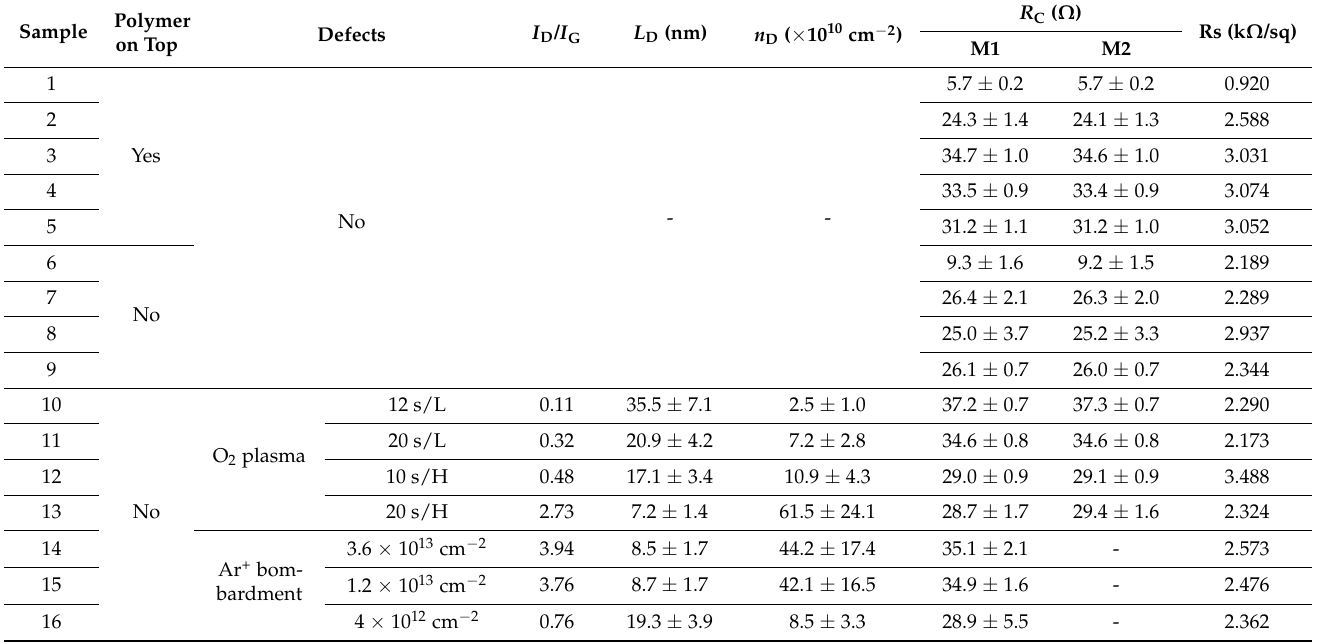
Table 2. Tested samples of 1L graphene on the Au electrode system. The conditions for the O 2 plasma etching denote treatment time/RF generator output power of 35 W (labelled as L) or 52.5 W (H). The note at the Ar + bombardment corresponds to the total ion dose delivered to the sample. M1 and M2 are the first, immediate measurement, and measurement after 14 days in an ambient environment, respectively. The I D / I G determination originates from Raman measurements using 532 nm and 633 nm laser excitation wavelengths for samples 10–13 and 14–16,